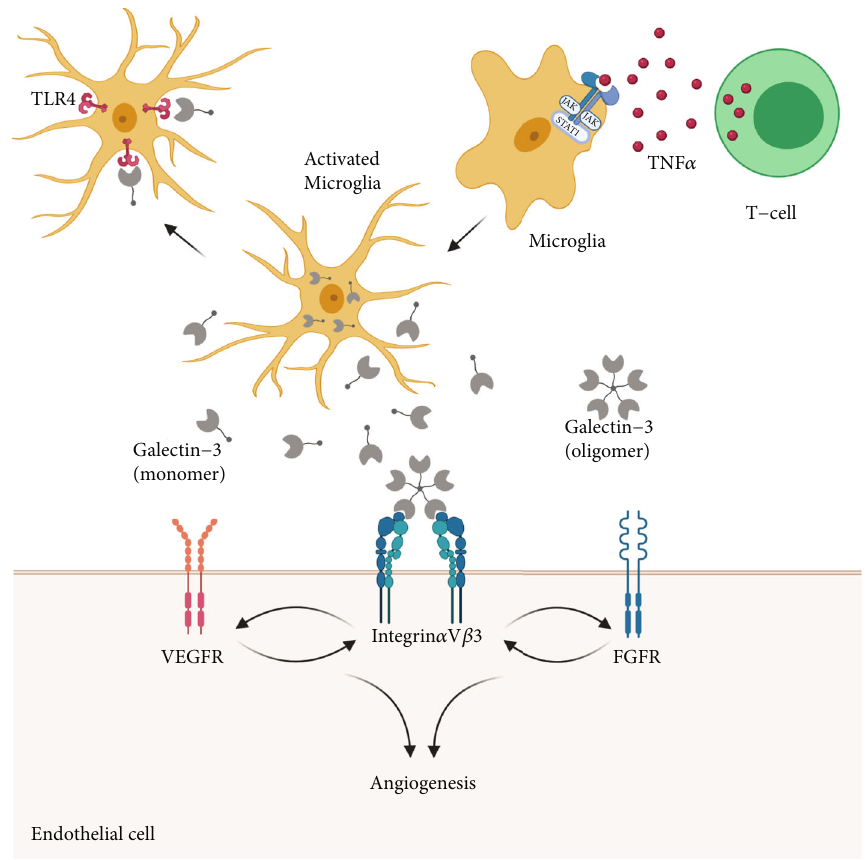
Figure 2: Potential e ff ect of galectin-3 during stroke. TNF α : tumor necrosis factor; TLR4: Toll-like receptor 4; VEGF: vascular endothelial growth factor; bFGF: basic fi broblast growth factor. This fi gure was created via BioRender